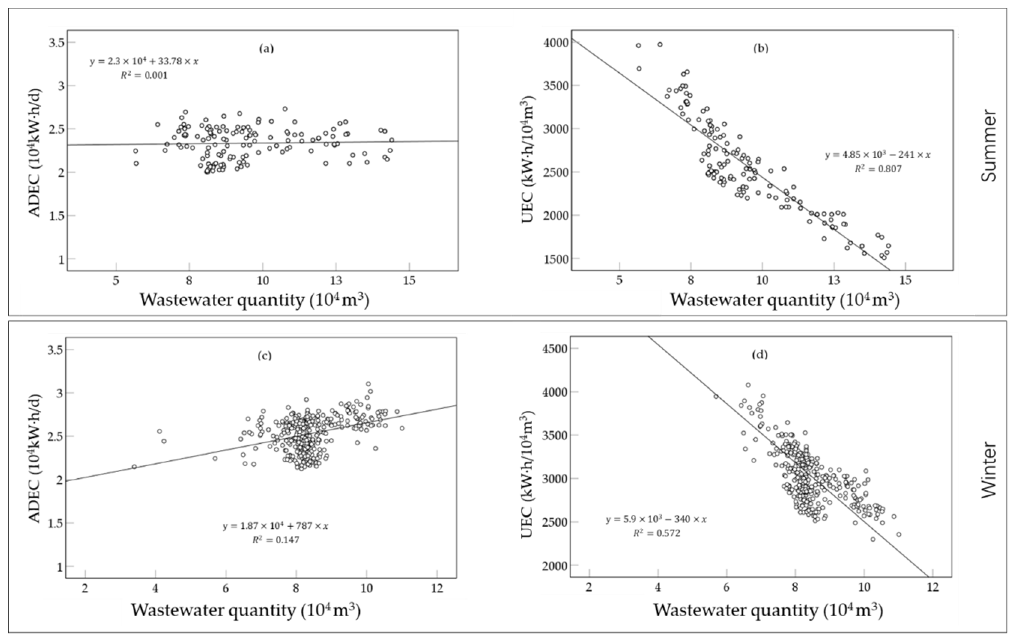
Figure 11. Variation of electricity consumption with wastewater quantity in different seasons. (Variation of ( a ) ADEC and ( b ) UEC in summer; Variation of ( c ) ADEC and ( d ) UEC in winter)